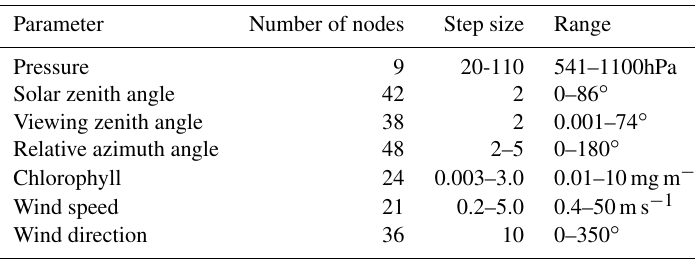
Table C1. LUT structure for TOA radiance